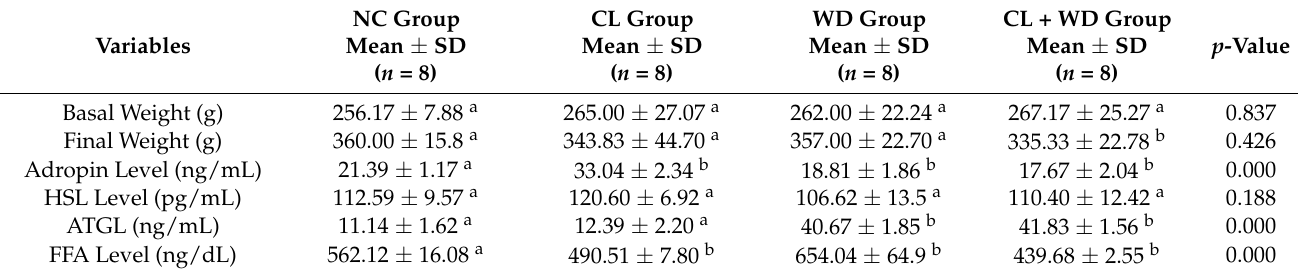
Table 2. Weight changes and lipid metabolism parameters among the studied groups ( n = 8 per each group).